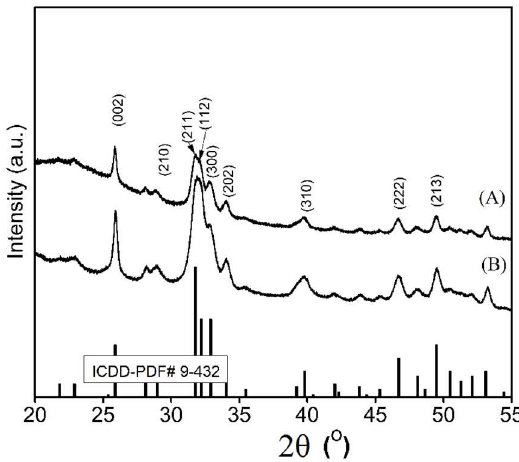
◦ C ( A ) and 700 ◦ C ( B